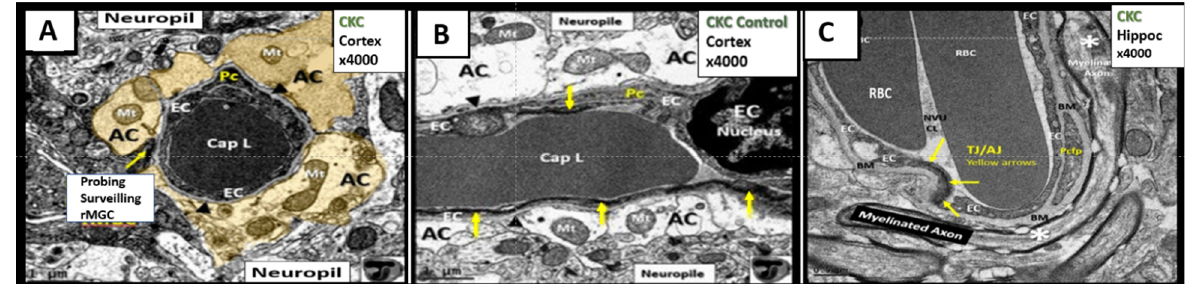
Figure 4. The neurovascular unit (NVU) in healthy control C57BL/6J mice at 20 weeks of age from cortical Layer III. Panel A astrocyte foot processes (AC) are pseudo-colored golden to emphasize their important anatomical location. Note the ramified microglial cell (rMGC) (yellow arrow) surveilling the NVU in Panel A. Panel B illustrates a horizontal image of the NVU (contrasting with the cross-section image in Panel A) to better illustrate the electron dense tight and adherens junctions (TJ/AJ) (yellow arrows) within the paracellular regions and emphasize the clear zone or corona of electron lucent AC foot processes (ACfp). Panel C depicts a NVU within the hippocampus where a myelinated axon bundle is present. Additionally, oligodendrocytes may exist in the NVU basement membrane (BM) especially in the subcortical and white matter regions (not shown). Note that the BM splits to encompass the pericyte foot processes (Pcfp). Magnification × 4000; scale bar = 1 µ m. Panels A and B are adapted with permission from reference [39]. AC = astrocyte; ACfp = astrocyte foot processes; BM = basement membrane; Cap L and CL = capillary Lumen of the NVU; CKC = control C57BL/6J model; EC = endothelial cell; Mt = mitochondria; rMGC = ramified MGC; Pc = pericyte; Pcfp = pericyte foot